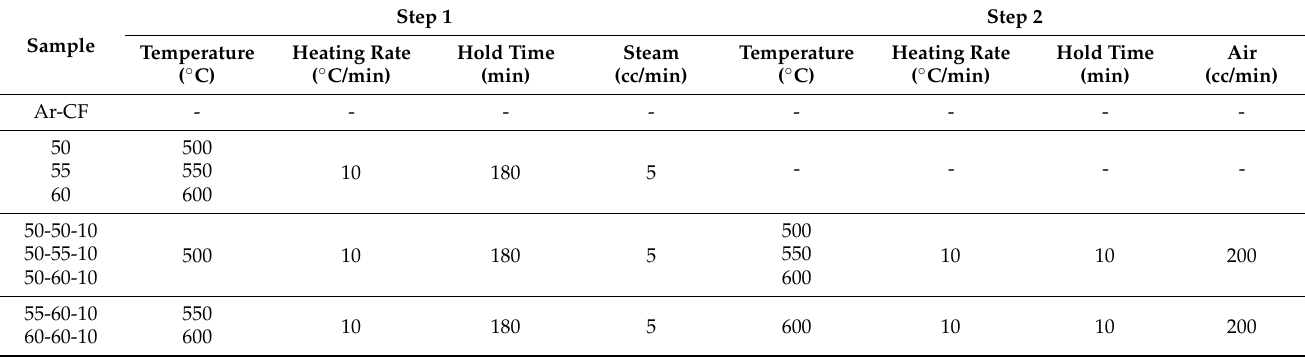
Table 1. Nomenclature for recycled carbon fibers and carbon fiber-reinforced plastics pyrolysis conditions.